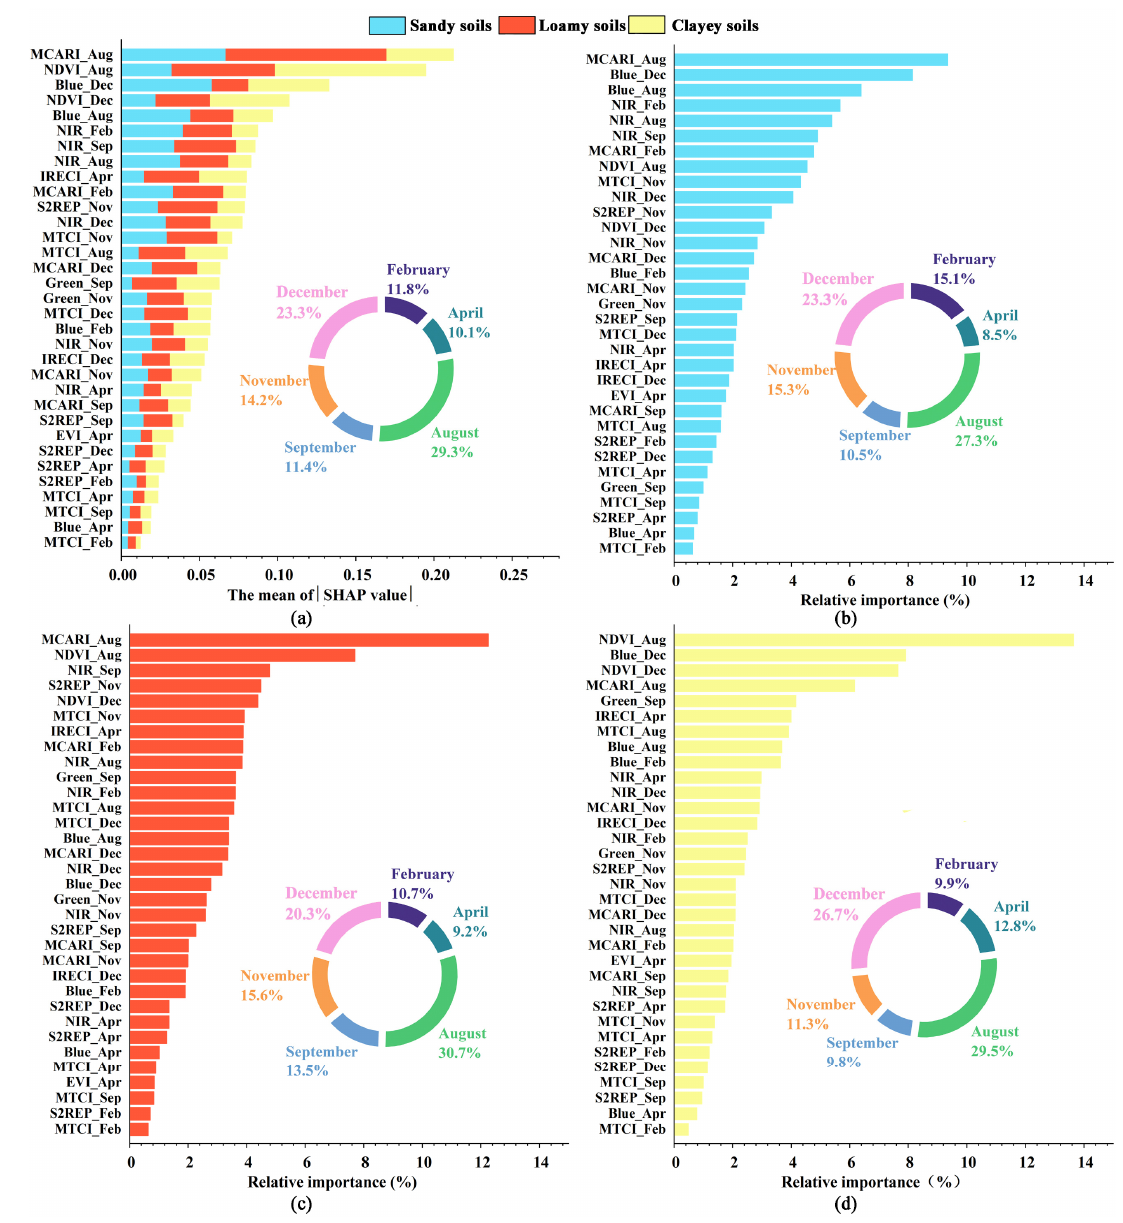
Figure 8. Variable ranking for ( a ) three different textural soils, ( b ) sandy soils, ( c ) loamy soils, and ( d ) clayey soils based on the SHAP value (Feb, Apr, Aug, Sep, Nov, and Dec mean February, April, August, September, November, and December, respectively).